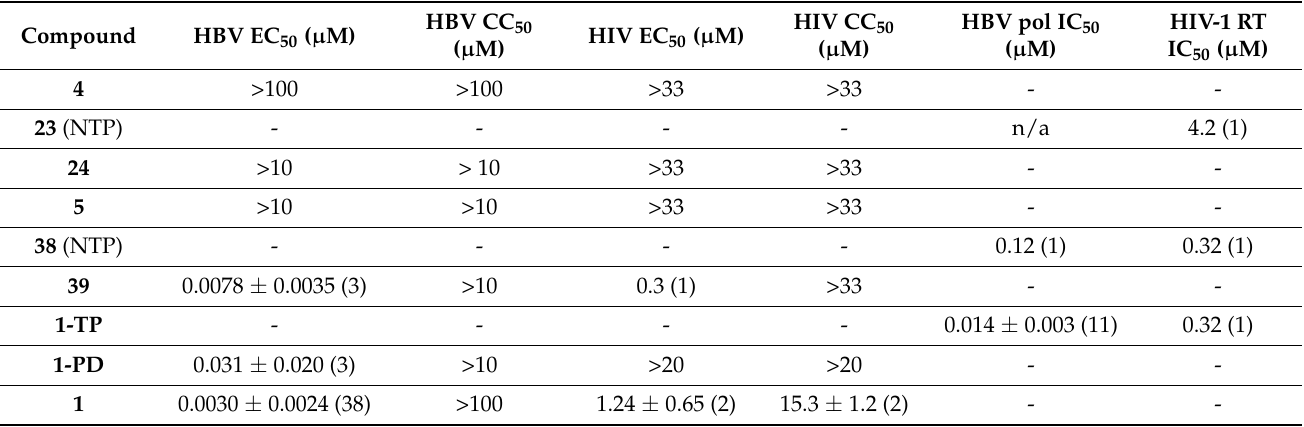
Figure 3. Structures of phosphoramidate prodrugs and tripohosphates of entecavir and synthe- sized apionucleosides. Table 1. Antiviral activities of 3’-fluoroapionucleosides, nucleotides triphosphates, and nucleoside phosphoramidate prodrugs.